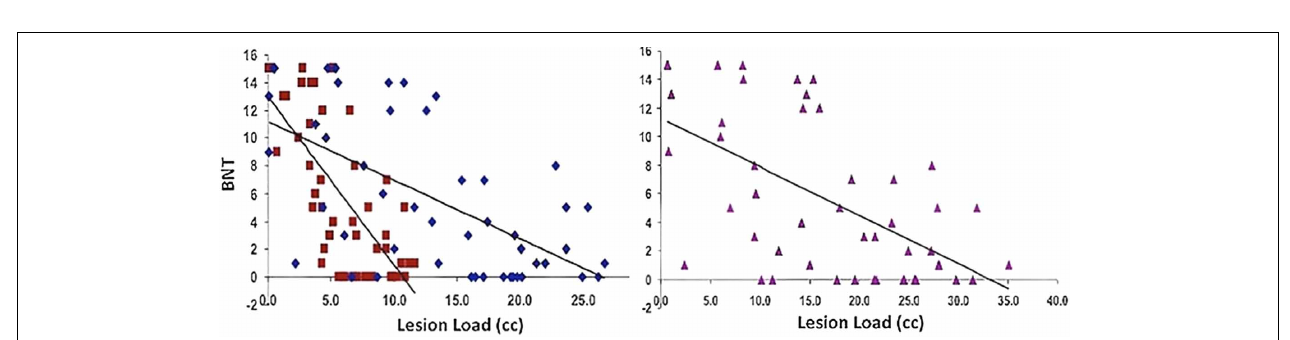
Figure 1 . All regressions are significant ( p < 0 . 01), and AF-LL significantly predicted better for naming ability through multiple regression analysis ( p < 0 . 05).